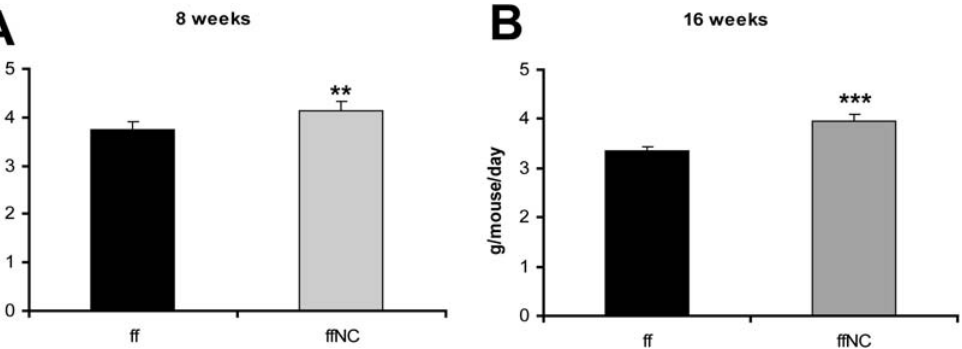
Figure 6. Food intake of Stat5 fl/fl and Stat5 fl/fl;Nestin-Cre mice was measured in a set of male mice (n=6 per group) at the age of 8-weeks (A) and 16 weeks (B). Data show the total grams of food consumed per mouse per day. Mice were housed individually for all measurements. Values are mean 6 SEM. At 8 weeks of age, Stat5 fl/f weighed 25.6 6 3.1 g and Stat5 fl/fl; Nestin-Cre was 23.9 + 3.2 g; at 16 weeks body weights were 28.1 6 3.3 vs 29.2 6 3.7 respectively. By Two Way Repeated Measured ANOVA there were no effect of genotype on body weight in this cohort of male mice, however the effect of genotype on food intake was significantly different (F(1,10)=5.7, p=0.038. All pairwise multiple comparison (Holm-Sidak test) revealed that food intake was significantly different between two groups at 16 weeks of age (P=0.0.005, t=3.2), but not at 8 weeks of age. doi:10.1371/journal.pone.0001639.g006 to 40% of LHA neurons (Figure 9B). Thus, GM-CSF increases hypothalamus in response to i3vt GM-CSF injection in rats, STAT5 nuclear accumulation in specific hypothalamic neurons, as consistent with GM-CSF-dependent activation and nuclear in peripheral target tissues [20]. In order to determine a potential accumulation of STAT5 isoforms in the hypothalamus role for STAT5 in the anorexigenic actions of GM-CSF, we (Figure 9A). Indeed, counting of STAT5-immunoreactive nuclei in examined the response of control and Stat5 fl/fl; Nestin-Cre mice to i3vt confocal images of these stained sections of rat brains revealed that i3vt GM-CSF administration doubled immunohistochemically- GM-CSF (Figure 9C). While i3vt administration of 1 m g of mouse detectable STAT5 nuclear accumulation from approximately 20% GM-CSF resulted in a significant reduction of food intake as early as